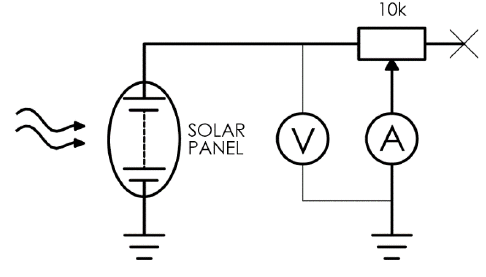
Figure 11. Scheme of the measurement circuit.